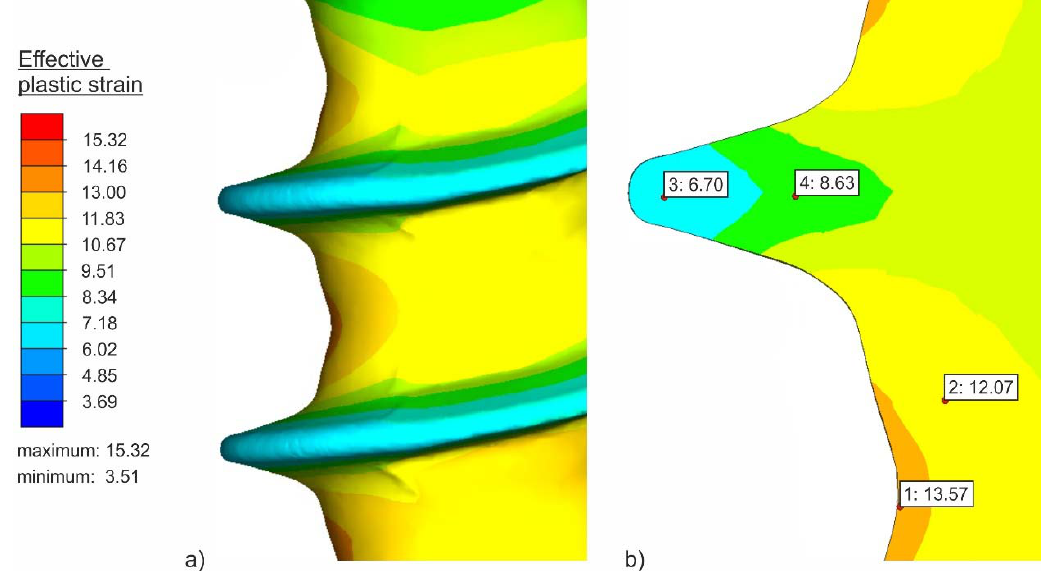
Figure 2. Finite element simulation of the strain distribution after thread rolling: ( a ) 3d view and ( b ) cut through area. The area at the thread root shows the highest introduced strain, whereas the strain introduced is lowest at the thread tip.